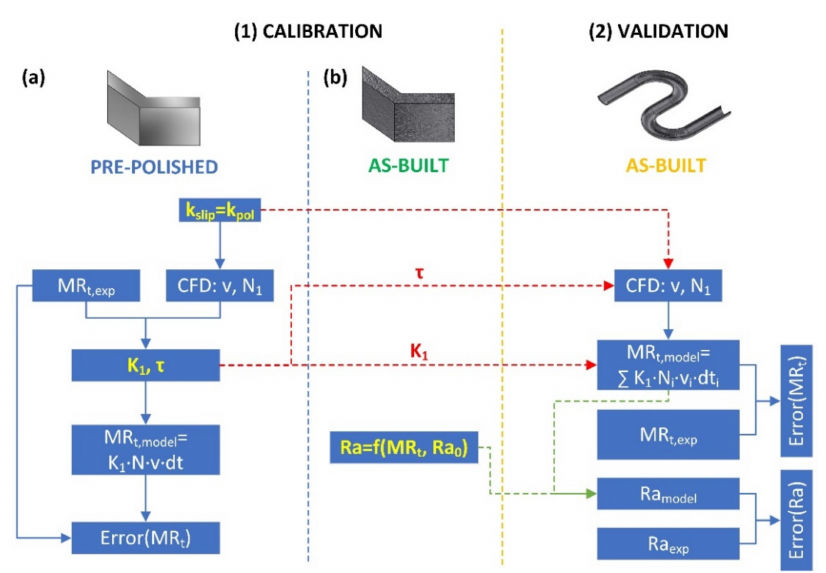
Figure 10. The MR model development workflow: (1) calibration using V-shape artifacts: ( a ) pre- polished, ( b ) as-built; and (2) validation using S-shape